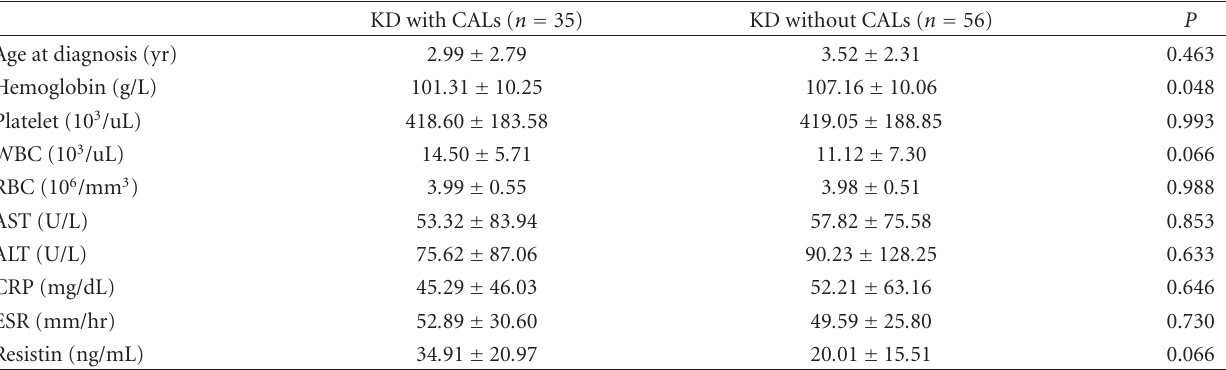
Table 2: Relation between clinical parameters in KD patients and development of CALs.